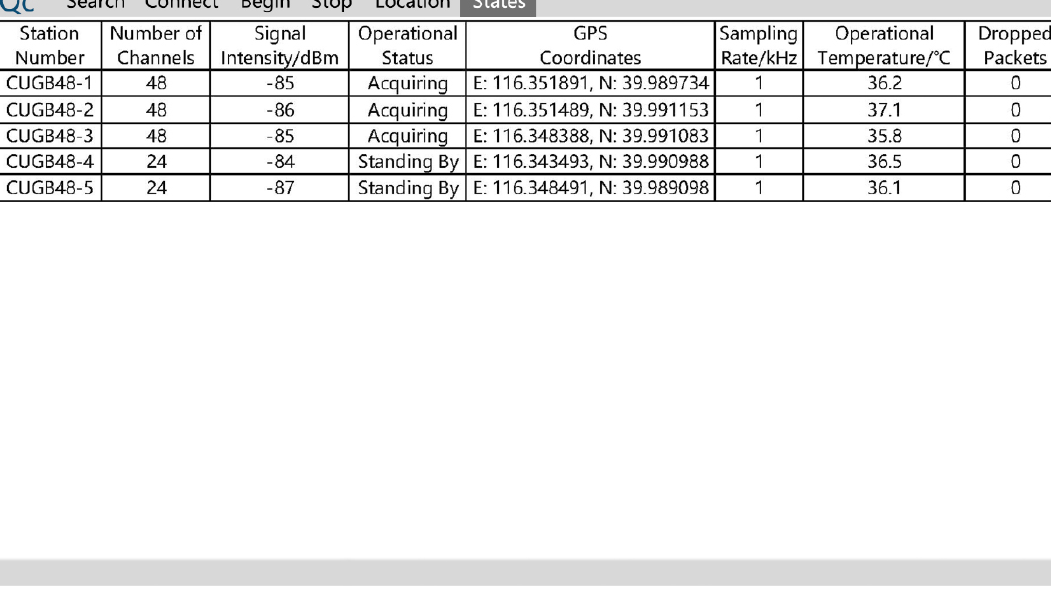
Figure 11. QC monitoring interface. Table 1. Comparison of parameters between 16SG24-N and